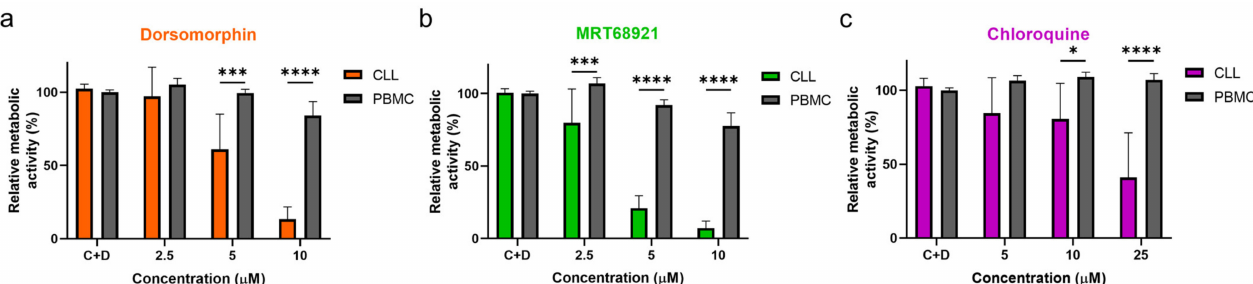
Figure 5. Autophagy inhibitors dorsomorphin, MRT68921, and chloroquine are selectively cytotoxic to CLL cells. CLL cells from 10 patients and PMBCs of five healthy donors (1 × 10 6 cells/mL) were treated with increasing concentrations of ( a ) dorsomorphin, ( b ) MRT68921, or ( c ) chloroquine for 24 h. Afterward, the metabolic activities of cells were determined using the PrestoBlue assay. Data are means ± SEM of ≥ 3 independent experiments, each carried out in duplicate. Two-way ANOVA with Sidak’s multiple comparisons test was used. ∗ , ∗∗∗ , and ∗∗∗∗ denote p < 0.05, p < 0.001, and p < 0.0001